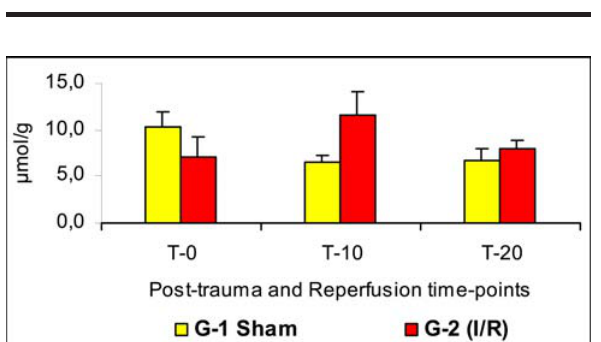
FIGURE 1 - Spinal cord pyruvate concentrations (n=6) in G-1 and G-2 groups tissue homogenates. Values are expressed as mean±S.E.M.